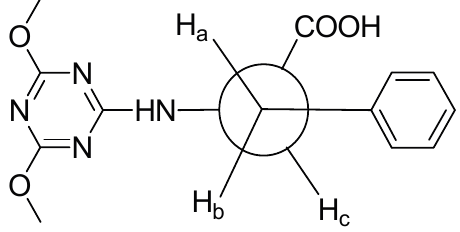
Figure 2. Newman projection formula for 2-(4,6-dimethoxy-1,3,5-triazin-2-ylamino)-3- phenylpropanoic acid 7